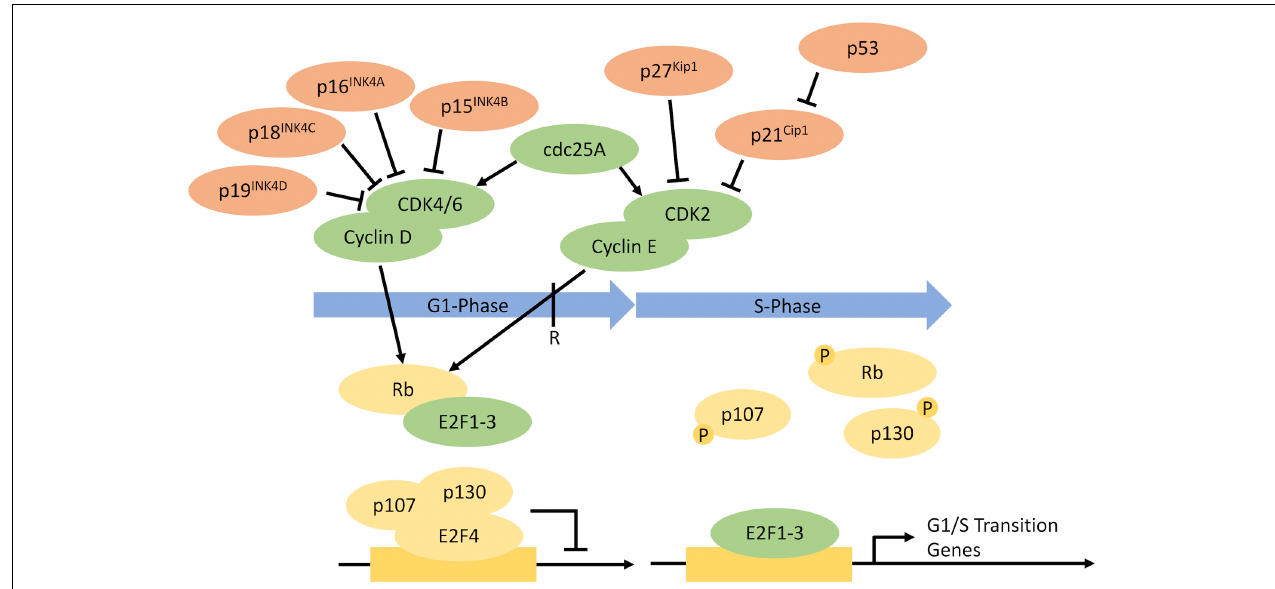
FIGURE 1 | Regulation of the progression through G1 phase into S phase (Sunley and Butler, 2010). The progression through G1 into S phase is governed by a series of cell-cycle regulators, with some regulators promoting progression and others inhibiting progression. CKIs for potential overexpression are shown in red. Potential targets for gene knockdown/protein degradation are shown in